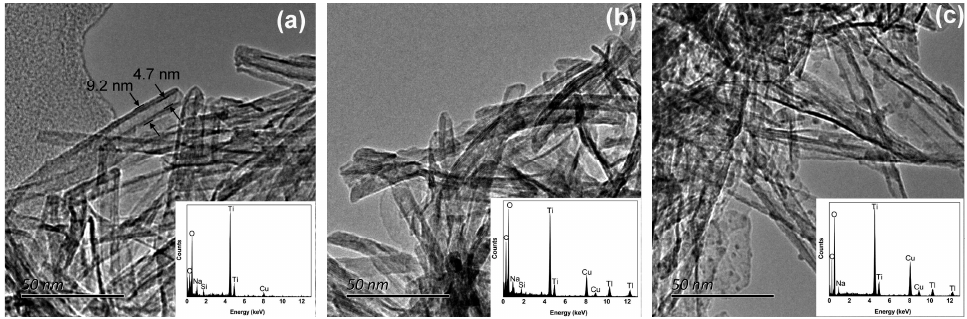
Figure 8. Electron micrographs of TNTs: ( a ) Before adsorption of Tl; ( b ) After absorption of thallium Tl(I); and ( c ) After absorption of thallium Tl(III) [36].